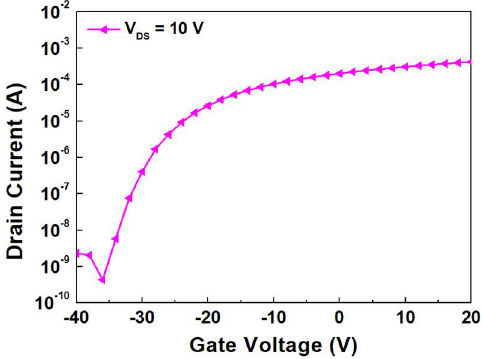
Figure 14. Completely depletion-mode a-IGZO TFT transfer characteristics.